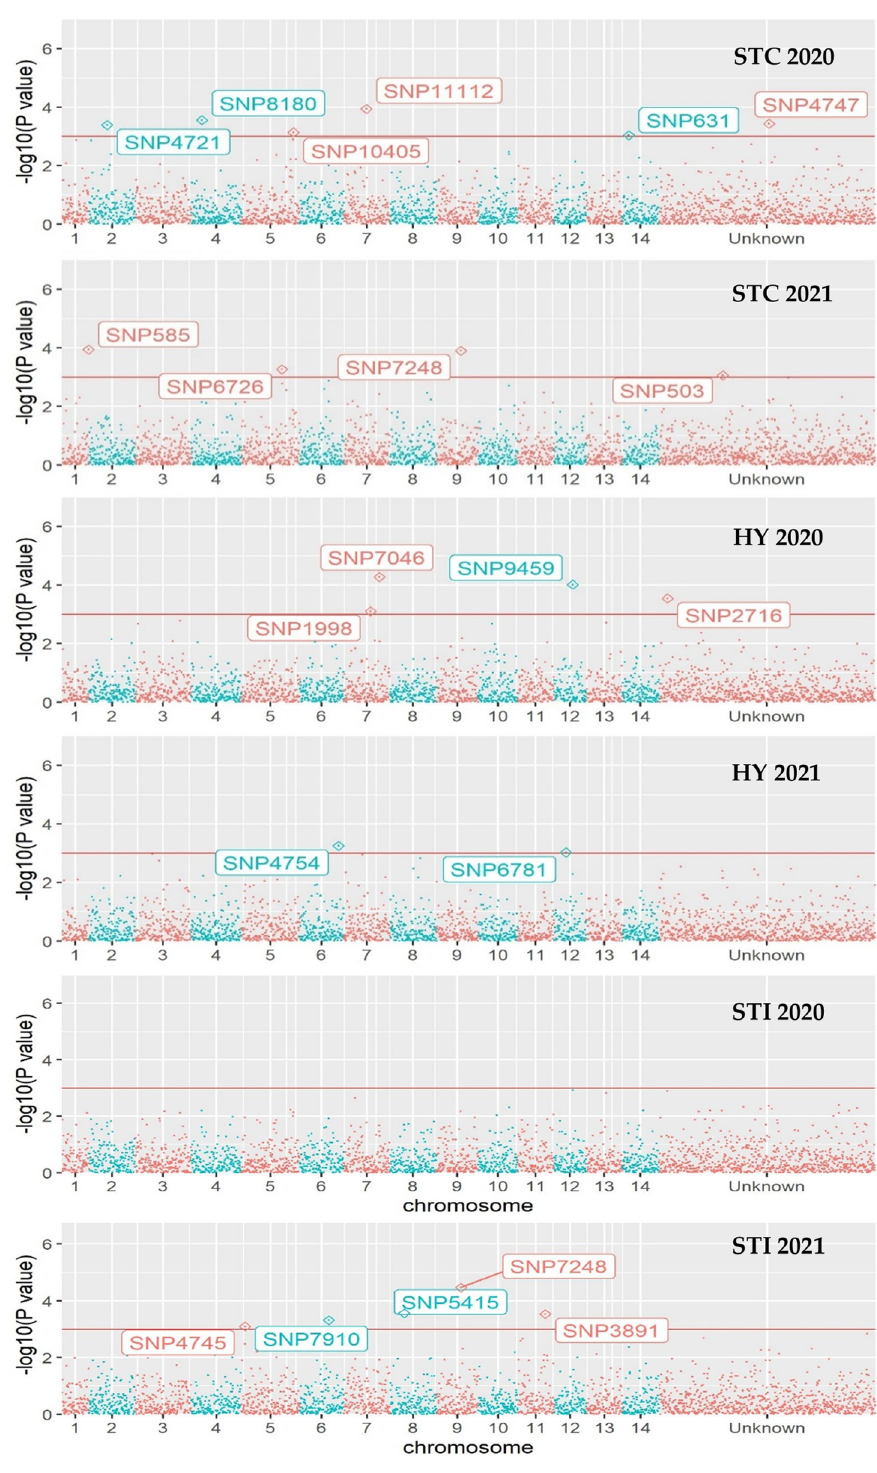
Figure 2. Manhattan plots showing distribution of SNPs across the macadamia genome and significance ( − log 10 p -value) of marker–trait associations for three traits in 2020 and 2021 in the combined panel ( M. integrifolia, M. tetraphylla, M. integrifolia × M. tetraphylla accessions). STC = log e (count of stick-tights), HY = log e (harvestable yield (count of nuts)), STI = logit(stick-tight incidence (STC/(STC + HY)).